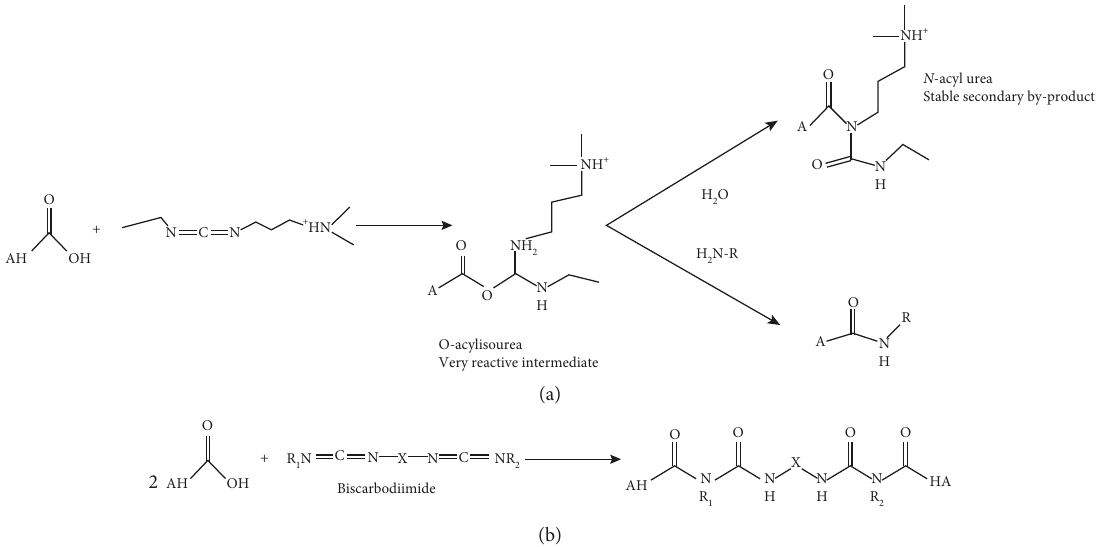
Figure 3: The HA amidation mechanism with EDC (a) and the cross-linking of HA with biscarbodiimides (b)